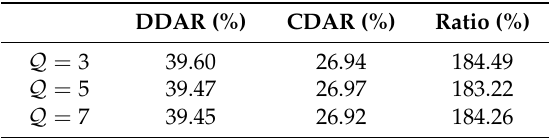
Table 9. Average energy efficiency and the ratio in each environment.